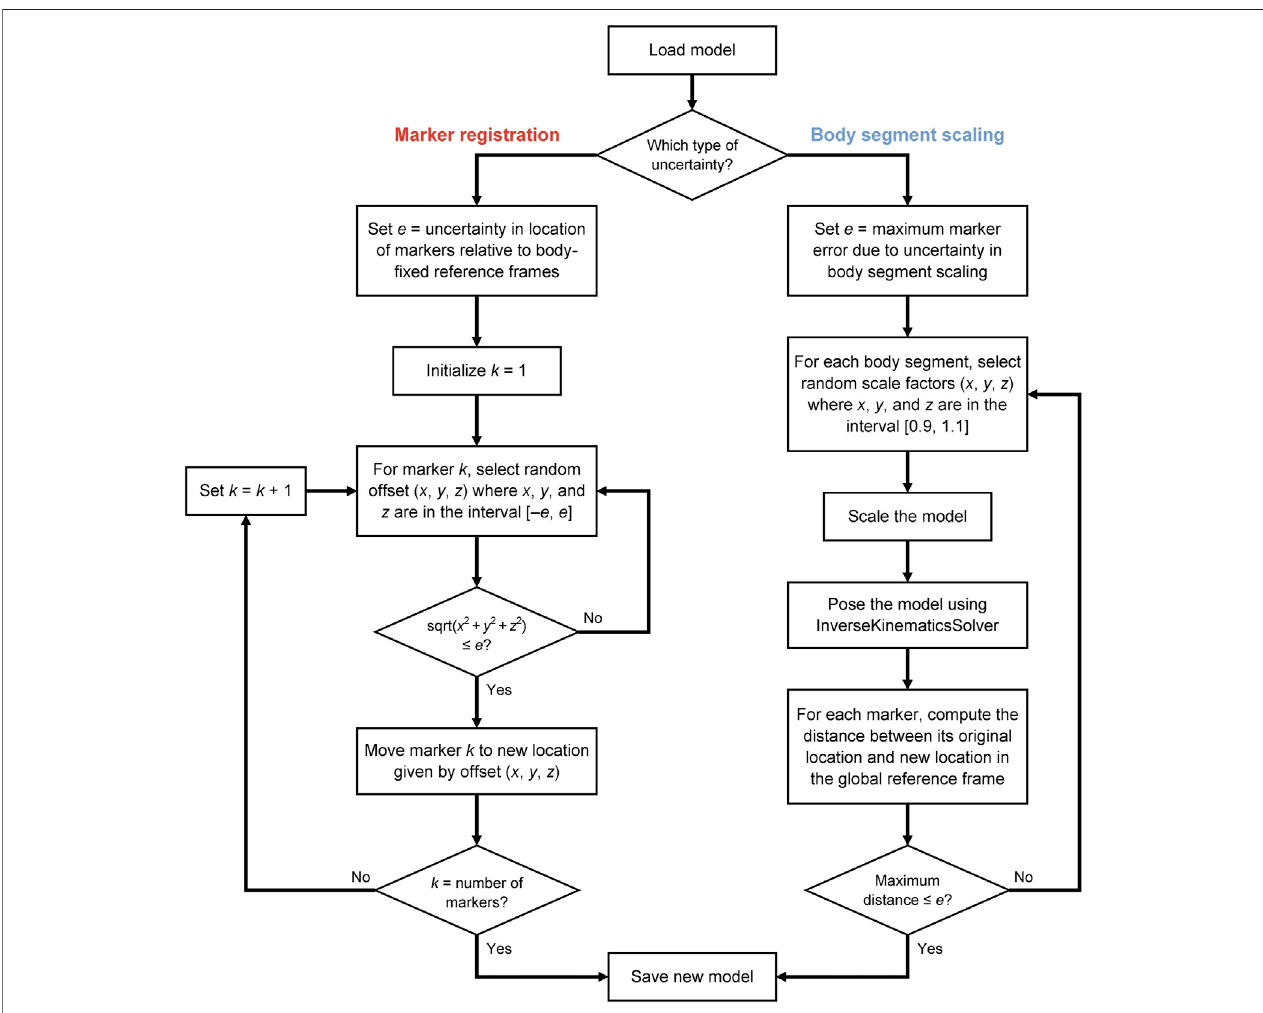
FIGURE 1 | Uncertainty propagation process for generating a population of skeletal models that all yield marker positions within a speci fi ed level of uncertainty.